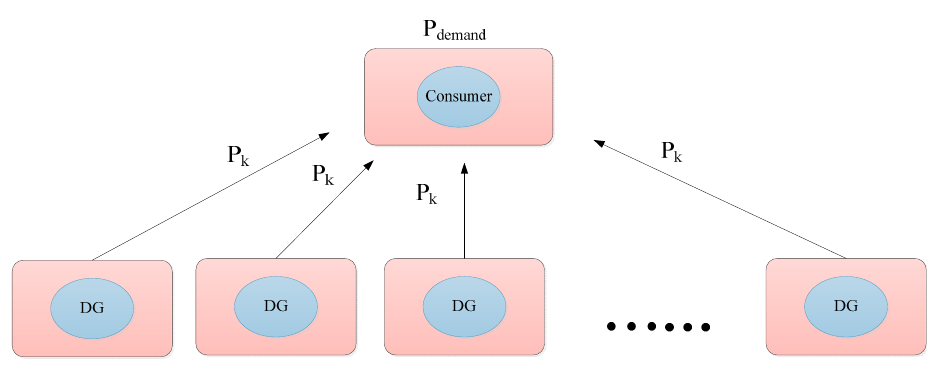
Figure 4. The diagram of Equation (11).